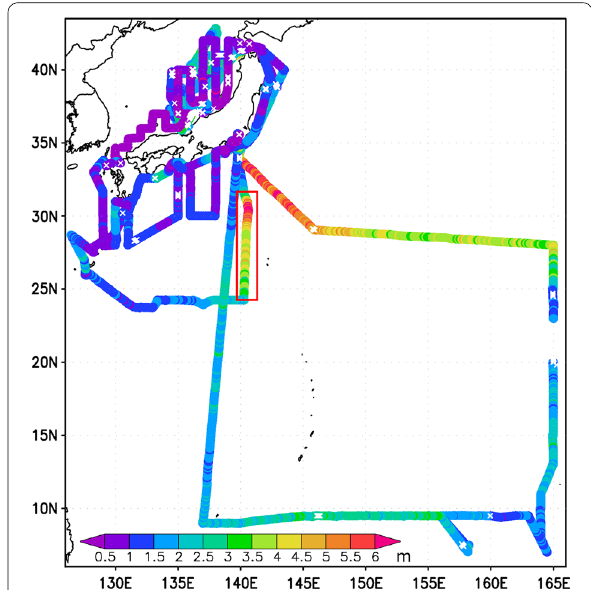
Fig. 13 Significant wave height along the RYOFU MARU trajectory. White crosses indicate the locations where the PWV data are judged as erroneous according to the study’s quality control process. The PWV time sequence in Fig. 7 is measured in the red rectangular area